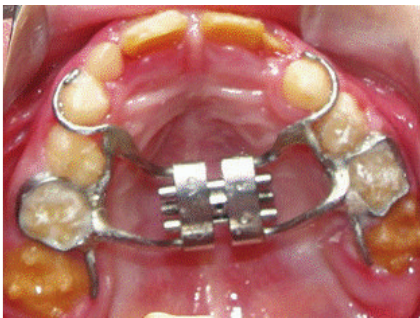
Figure 5: Intraoral view showing early orthodontic treatment interceptive and minimal intervention.